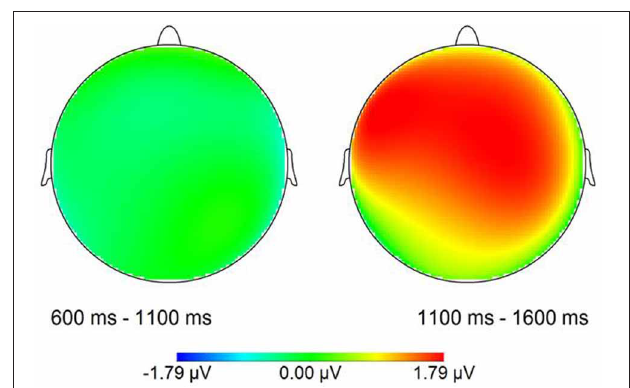
FIGURE 3 | Voltage maps of difference waves (adjusted to a prestimulus baseline of 200ms) for the critical time windows used in the first statistical analysis relative to stimulus onset (see below for